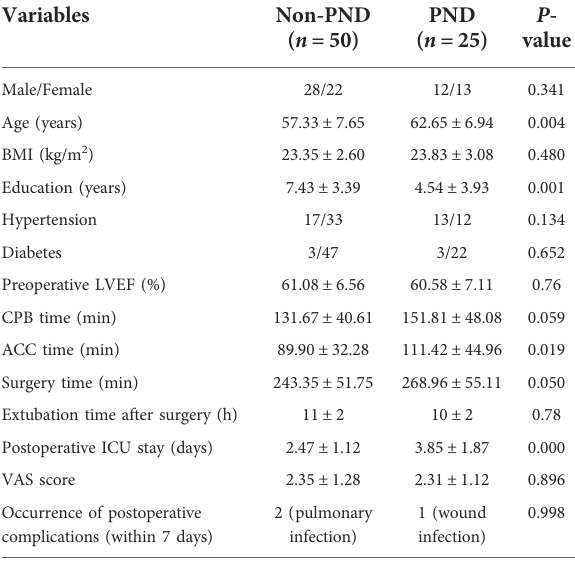
TABLE 1 Characteristics of the study population.